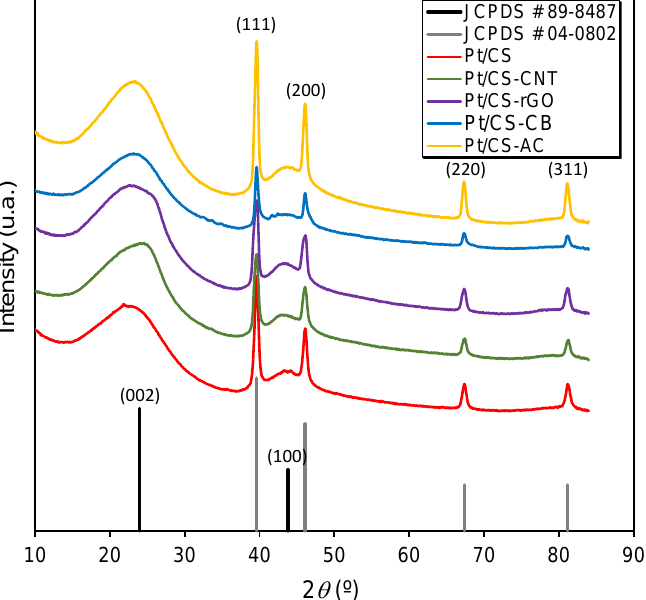
Figure 3. FTIR-spectra before and after thermal carbonization of some selected samples.